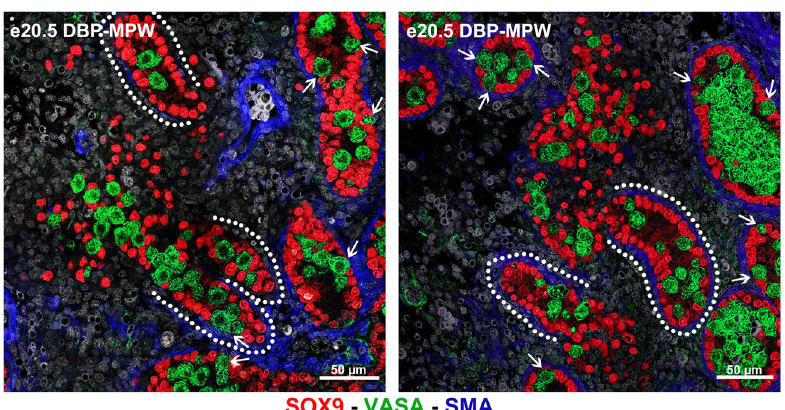
Figure 4. Evidence for seminiferous cord rupture as the source of focal dysgenetic areas in DBP-MPW animals. At e20.5, several examples of seminiferous cords in the process of breaking up could be found in testes of DBP- MPW exposed animals, delineated by the white dotted lines. Rupture can be seen to be releasing Sertoli (red) and germ cells (green) from the cords into the interstitial compartment. Sections were triple immunostained for SOX9 (red, Sertoli cells), VASA (green, germ cells), and smooth muscle actin (blue, peritubular myoid cells, blood vessels). Note the lack of SMA immunoexpression at the point where cord rupture appears to be happening, whereas SMA immunoexpression is present at the intact end of the seminiferous cords. Arrows = germ cells that have migrated to the basal